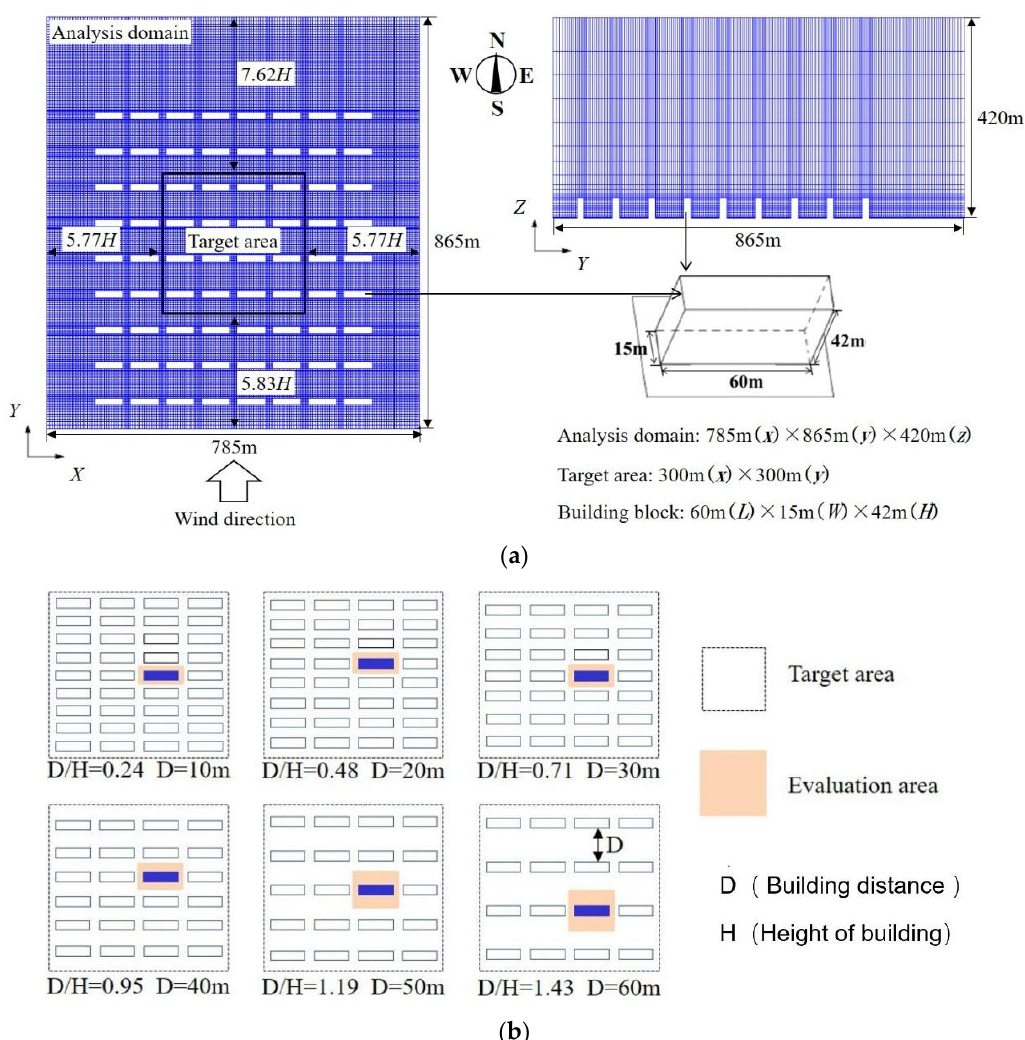
Figure 6. Analysis model used in this study. ( a ) Size and mesh of analysis model. ( b ) Different D/H and arrangement in the target area.